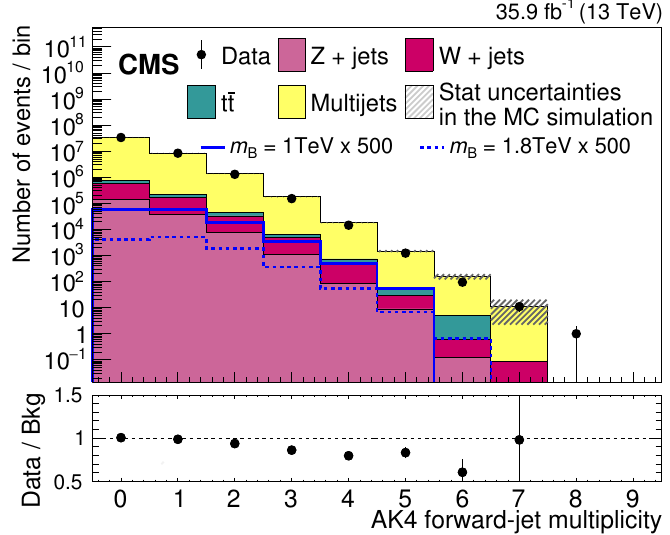
Figure 3. Multiplicity of forward jets before event categorization. The normalization of the signal contributions is multiplied by a factor of 500. All the contributions to background are obtained from Monte Carlo simulation and are normalized to data. The lower panel shows the ratio of data to background. We show only the statistical